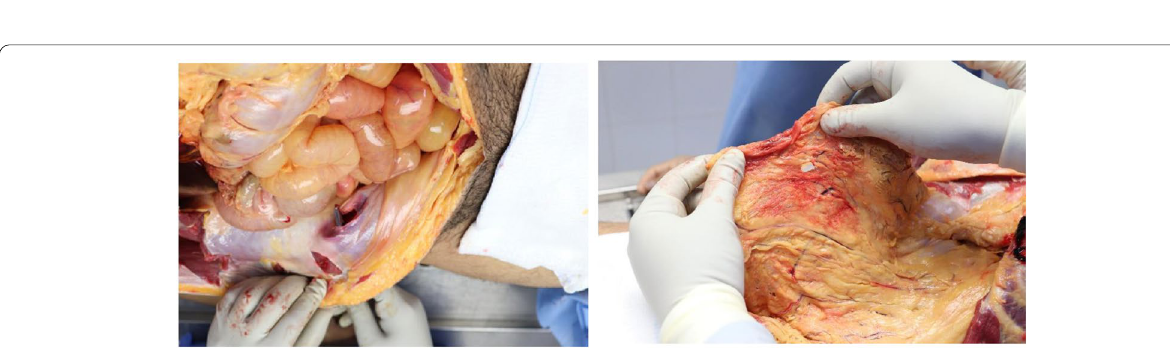
Fig. 4 Abdominal wound: penetrating peritoneum into the small intestine with non-obvious